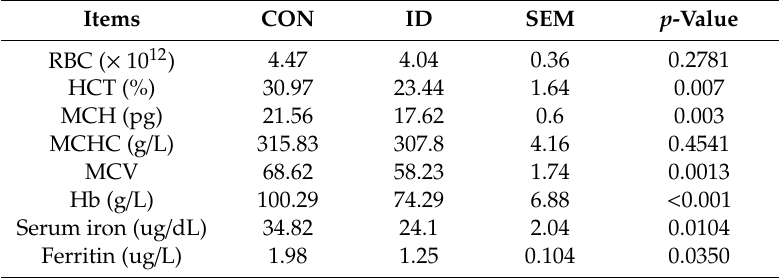
Table 2. Iron status biomarkers of neonatal piglets with or without iron